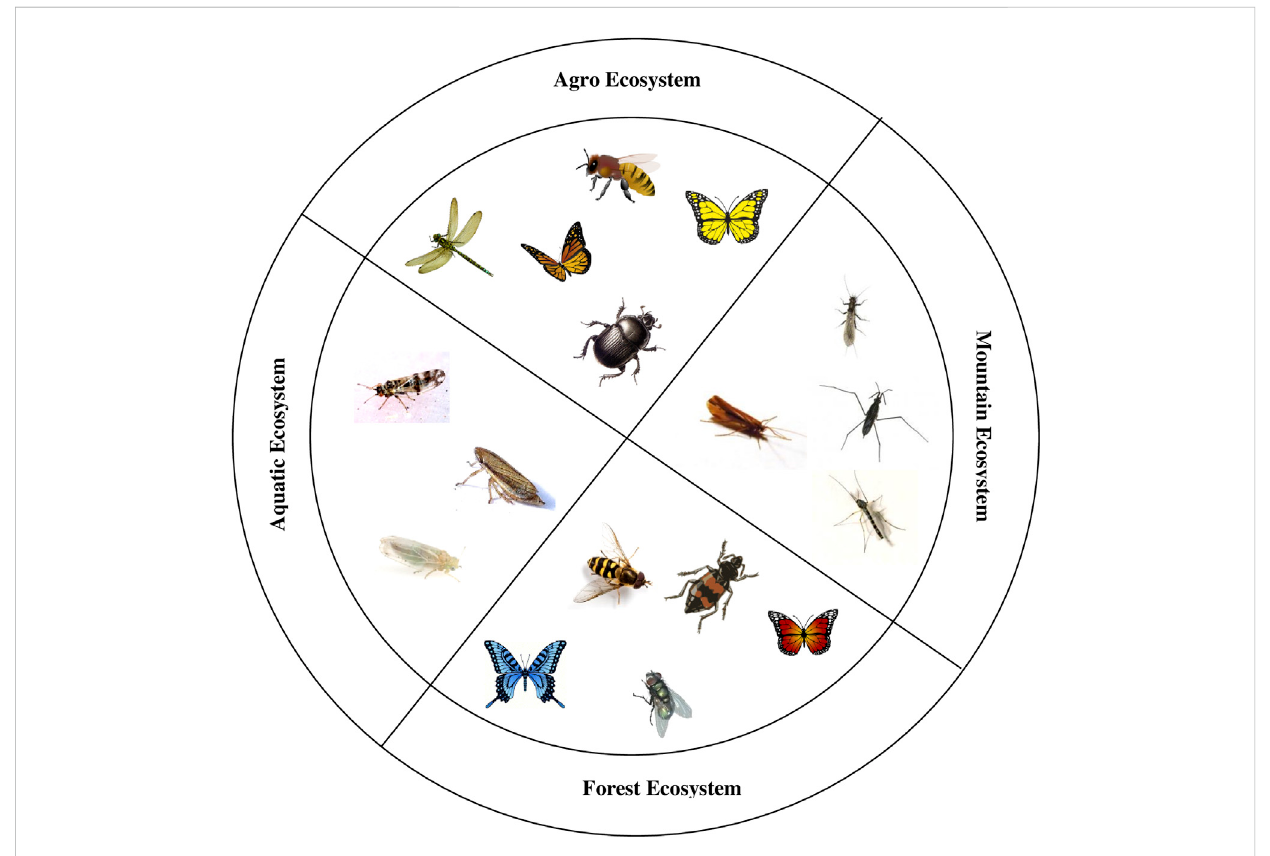
FIGURE 5 Insect bioindicators of different